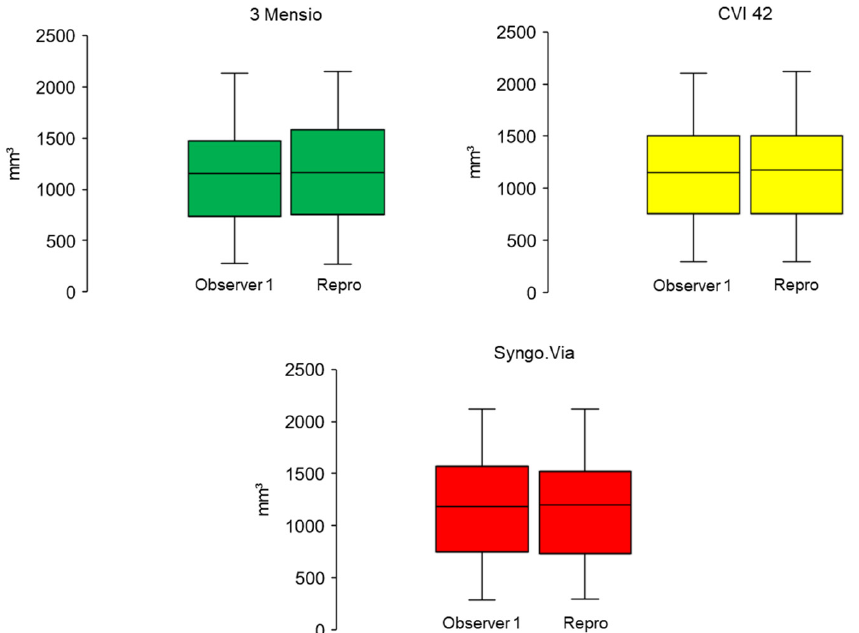
Figure 6. Intra-observer AVC measurements for the three different software solutions. An illustra- tion of the AVC measured in the intra-observer setting. No significant differences were found. ( t - Test for paired, normally distributed samples; 3 Meniso p = 0.209, CVI 42 p = 0.114, Syngo.Via p = 0.123). AVC: aortic valve calcification.